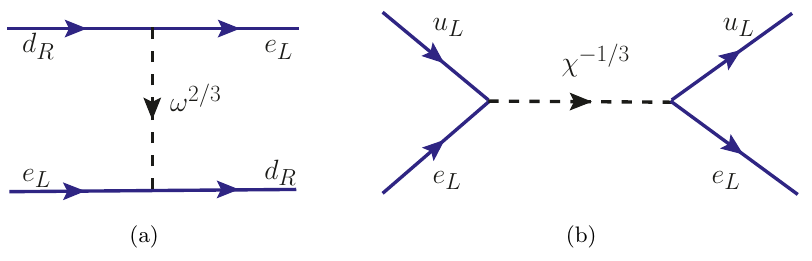
Figure 23 . Doublet and singlet LQ contribution to APV at